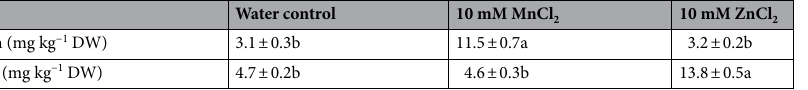
Table 1. Mineral element accumulation (mg kg −1 dry weight) in stored soya bean sprouts after spraying with 10 mM MnCl 2 or ZnCl 2 . Means associated with the same letter are not significantly different for each element ( n = 3; P < 0.05). DW dry weight.